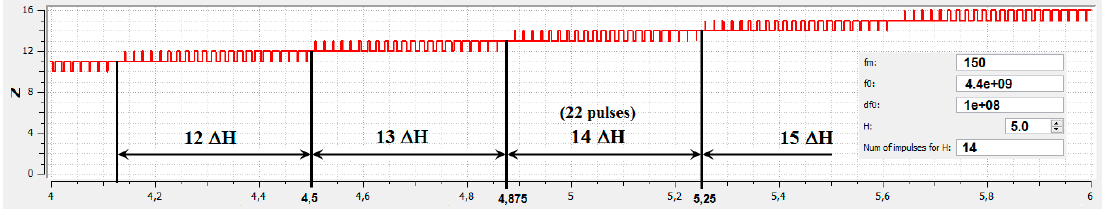
Figure 7. Unstable height pulses of radio altimeter with extreme bandwidth.